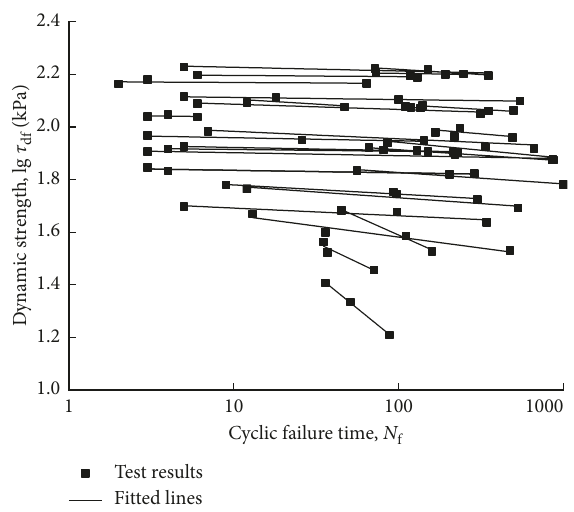
Figure 8: Relationship between τ